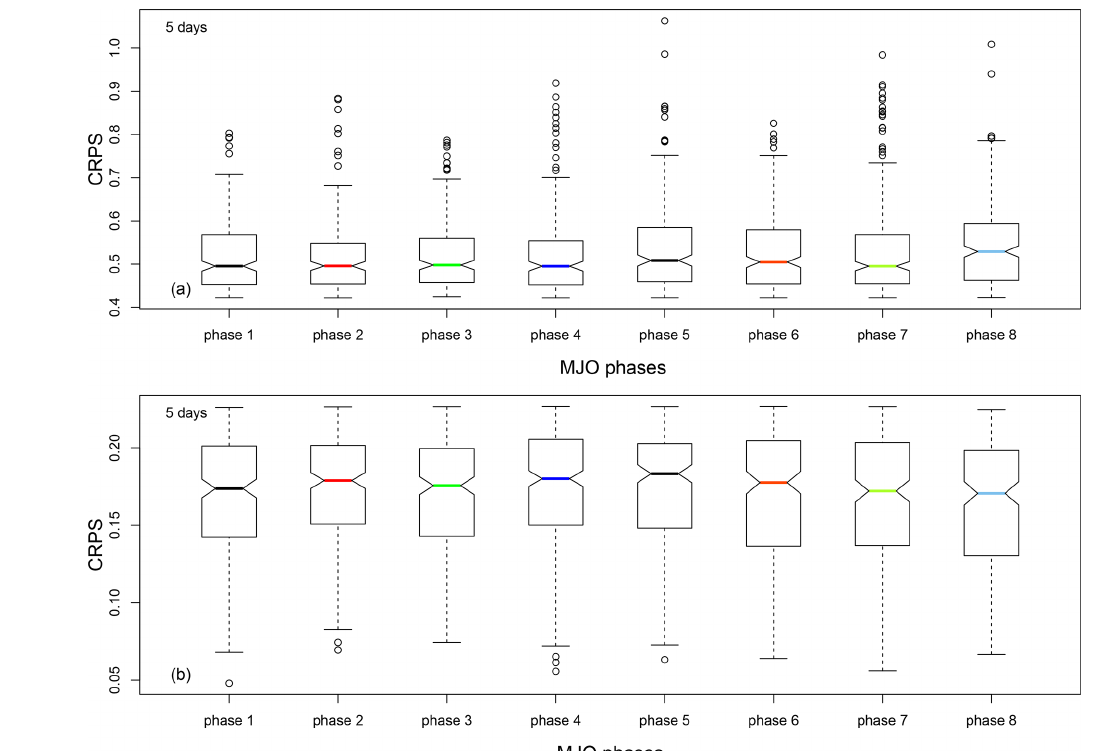
Figure C1. Relationship between CRPS and MJO phases. (a) CRPS values above the 75th quantile and (b) CRPS values above the 25th